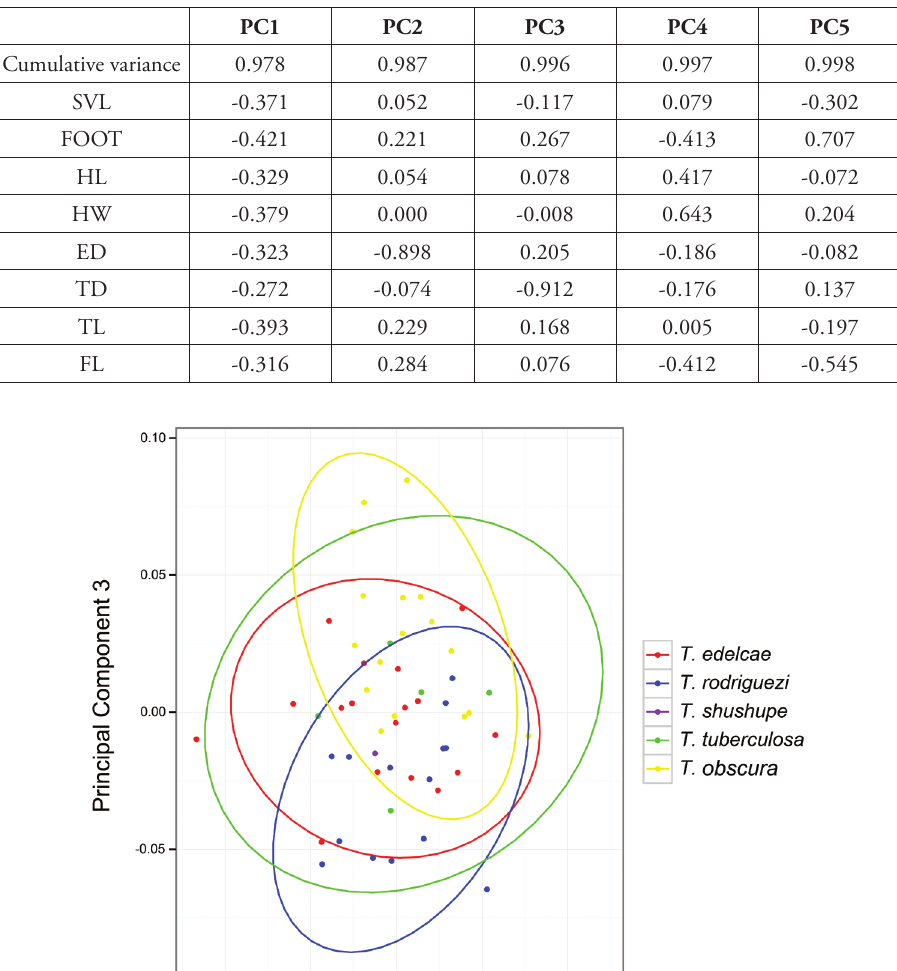
Table 2. Character loadings and cumulative proportion of variance for Principal Components. The analysis was based on eight morphometric variables of adult males of Tepuihyla tuberculosa comb. n., Tepui-